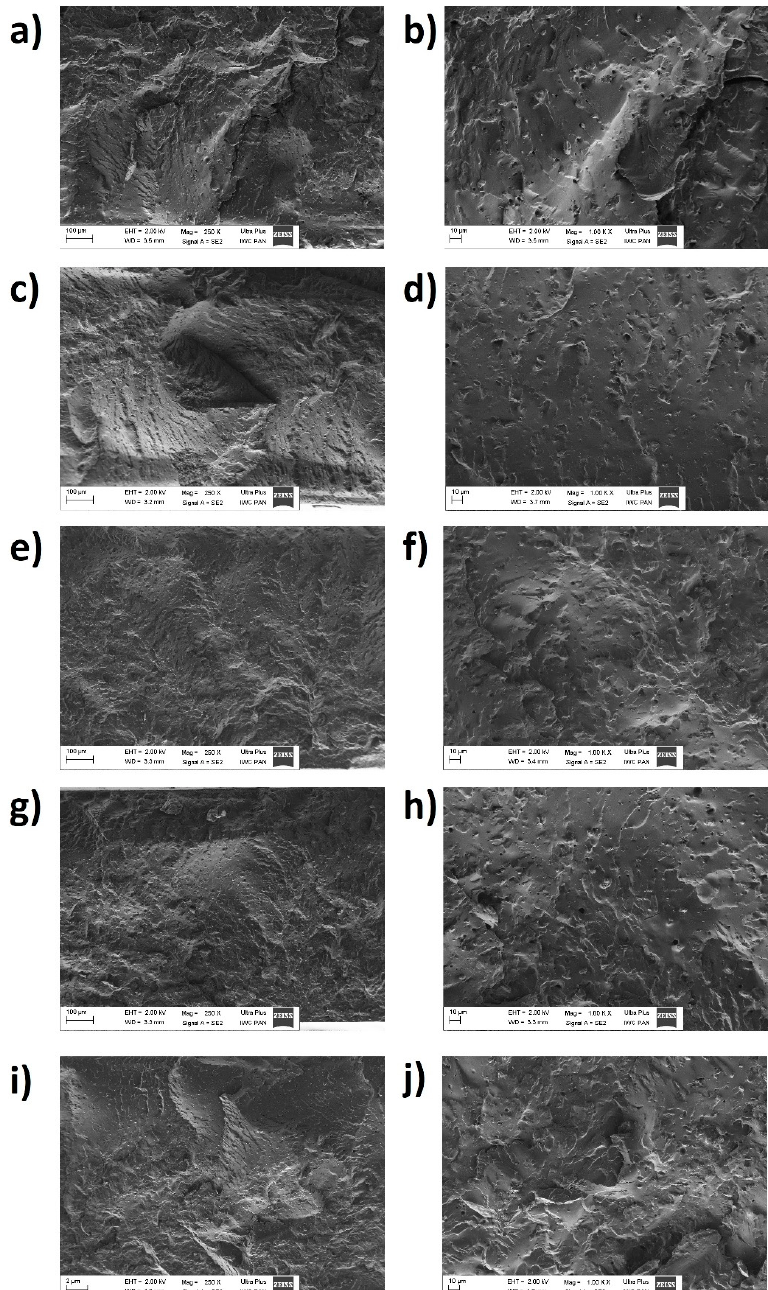
Figure 3. SEM images for: reference sample of ENR/PLA blend ( a , b ), ENR/PLA + δ -tocopherol ( c , d ), ENR/PLA + curcumin ( e , f ), ENR/PLA + β -carotene ( g , h ), ENR/PLA + quercetin ( i , j ) with magnifications, respectively, 250 and 1000.